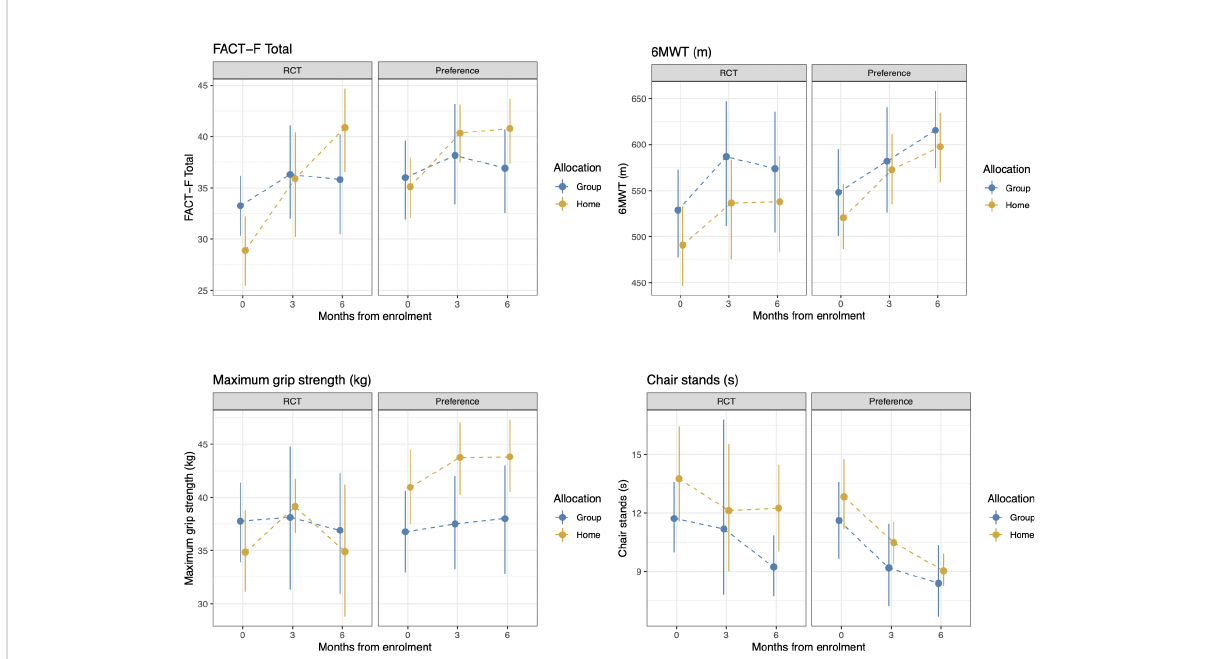
FIGURE 3 Changes in FACT-F, 6MWT, grip strength, and chair stands from baseline to 6 months between HOME and GROUP participants in the RCT and the preference trial. Higher scores represent less fatigue, greater walk distance, greater grip strength, and longer time to complete the chair stands